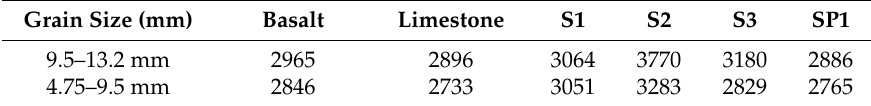
Table 9. Angularity of investigated coarse